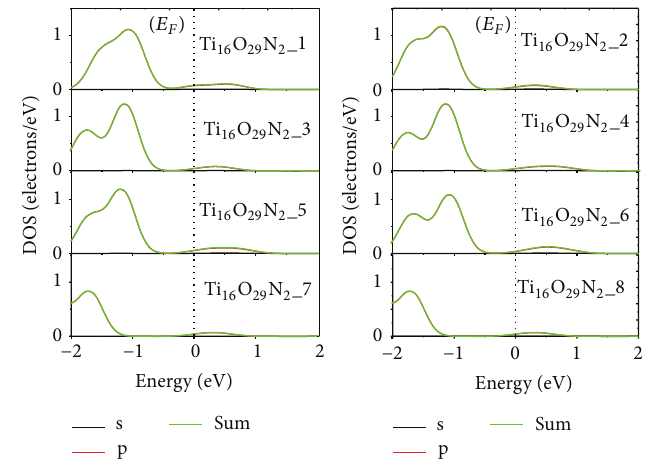
Figure 11: The DOS of N atom of eight